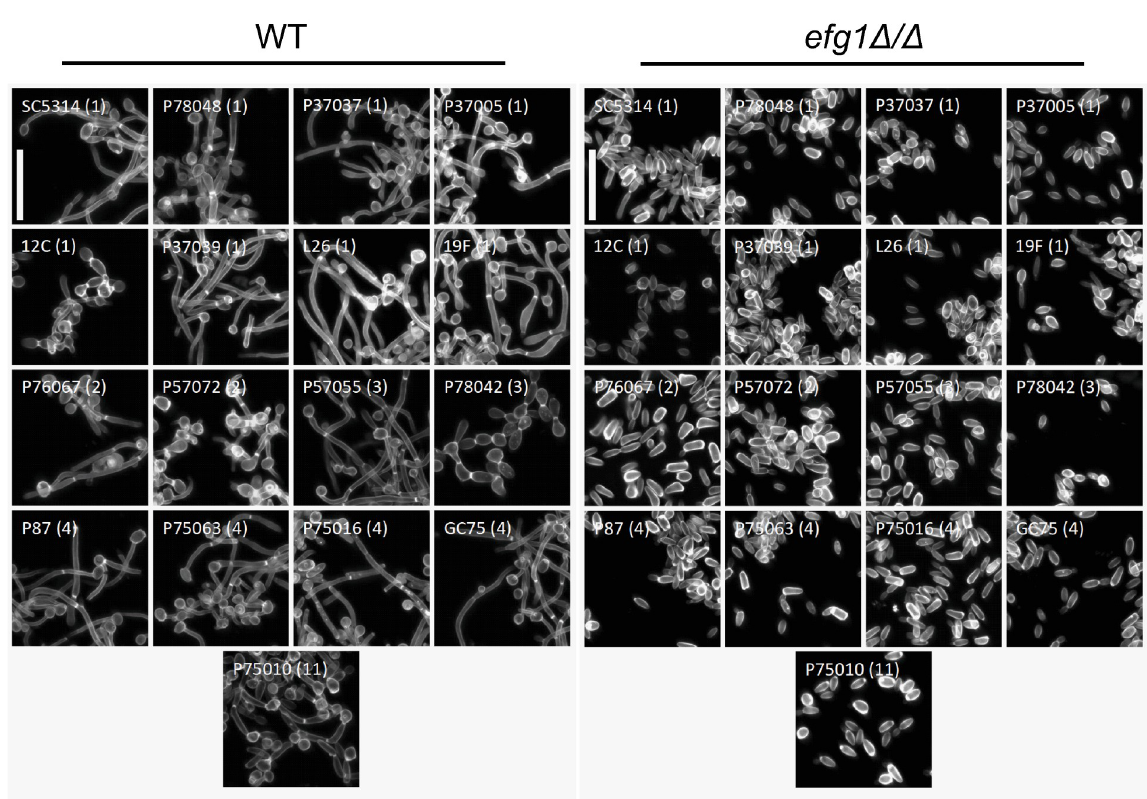
Fig 1. Hypha formation ability. Confocal images of clinical isolate WT (Left) and efg1 Δ / Δ (Right) planktonic hyphal formation in liquid RPMI +10% serum at 37˚C for 4hr. Samples were fixed in 4% formaldehyde in 1X PBS and stained with calcofluor white. White scale bar indicates 25 μ m. Clade number is designated in